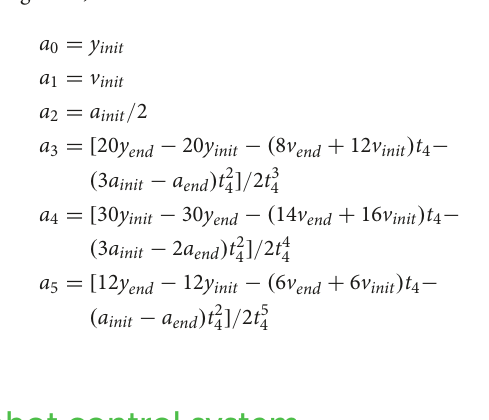
FIGURE10 Screenshot of movement process: (A) Mode switching process diagram; (B) Jump process diagram.